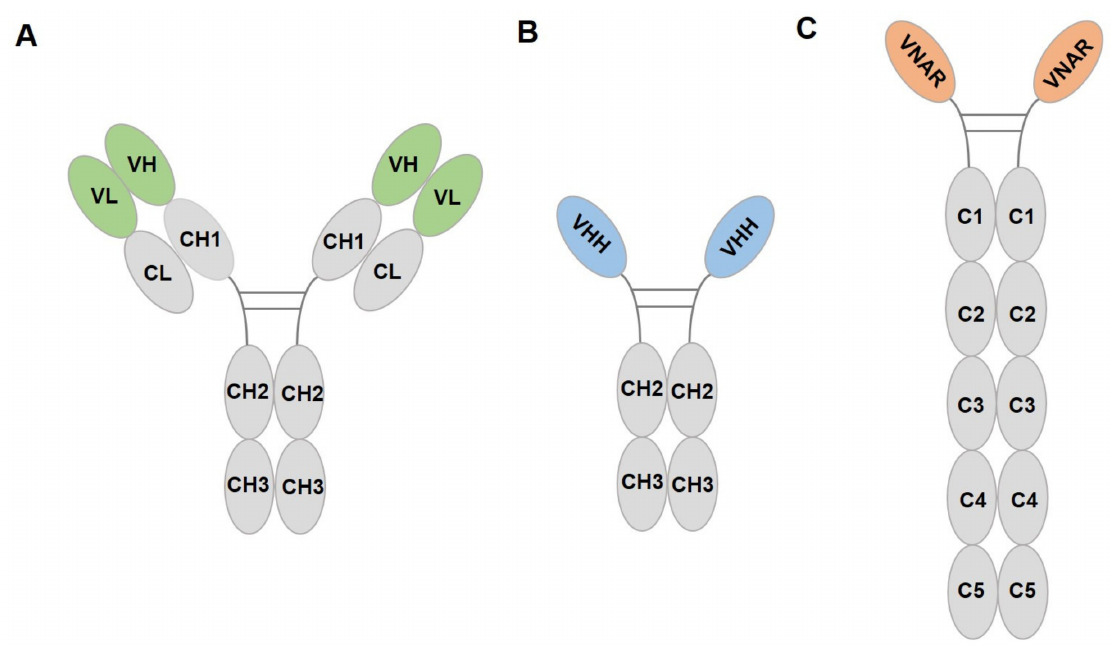
Figure 1. Structure diagrams of IgG ( A ), camelid HCAb ( B ), and shark IgNAR ( C ). VH, variable region of heavy chain; VL, variable region of light chain; CH/C, constant region of heavy chain; CL, constant region of light chain; VHH, variable domain of HCAb; VNAR, variable domain of